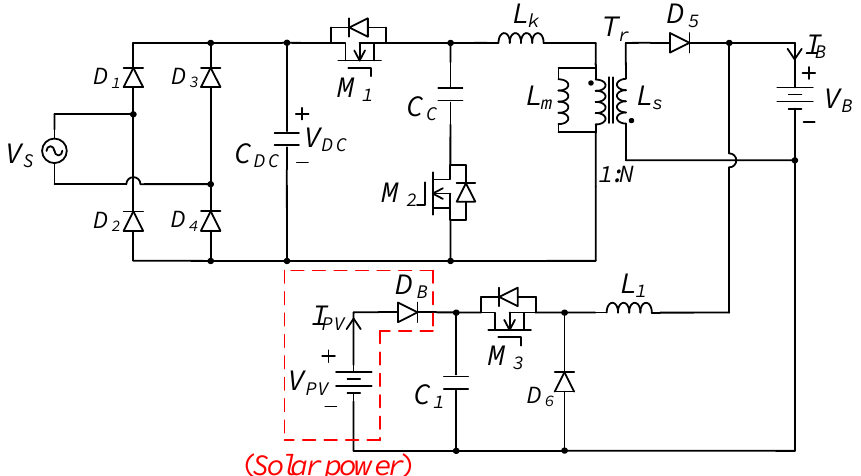
Figure 3. Schematic diagram of the conventional flyback/buck hybrid converter with utility line and PV arrays sources for lithium battery charger system.